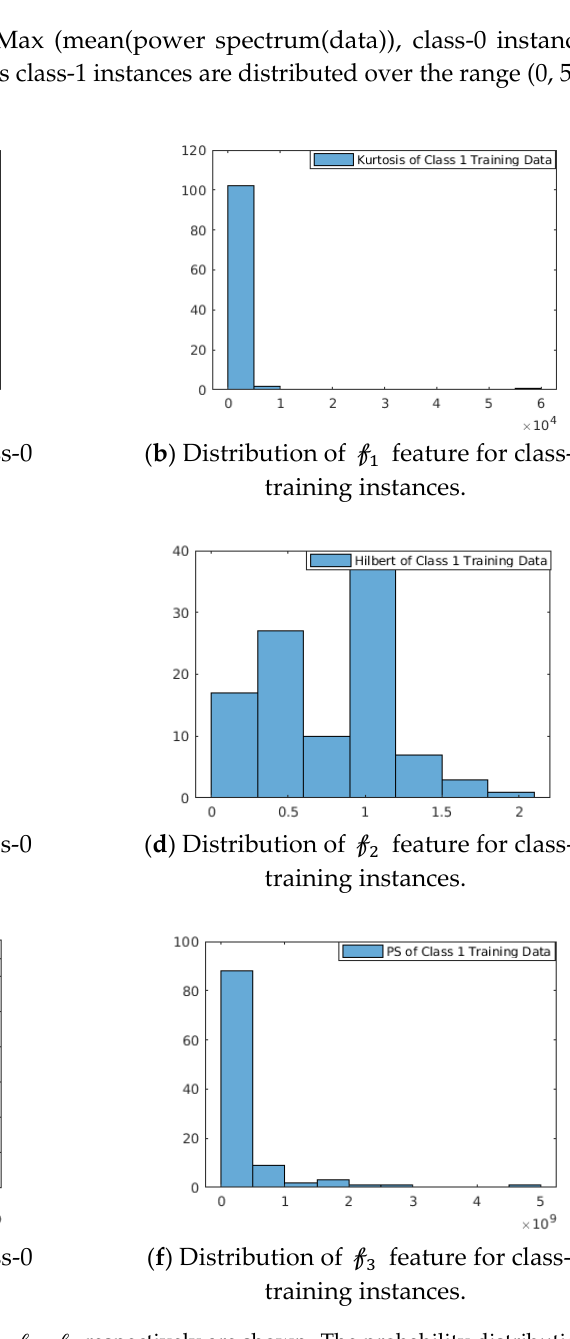
Figure 4. Strength of the three features 𝒻 1 , 𝒻 2 , 𝒻 3 respectively are shown. The probability distribution over the training datasets of the selected features for two different classes demonstrate distinctive characteristics.